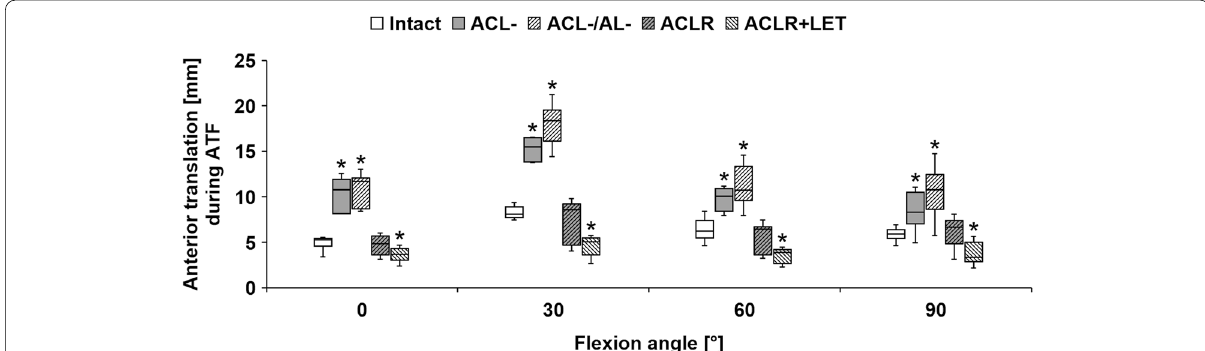
Fig. 7 Anterior translation during the application of anterior tibial translation force (ATF), in comparison between the intact state, state with resected anterior cruciate ligament (ACL-), state with resected ACL combined with anterolateral rotatory instability (ACL-/AL-), state with ACL reconstruction (ACLR), and state with ACLR and addition of a lateral extra-articular tenodesis (ACLR Significant differences from the intact state are marked with an asterisk (*) for each flexion angle